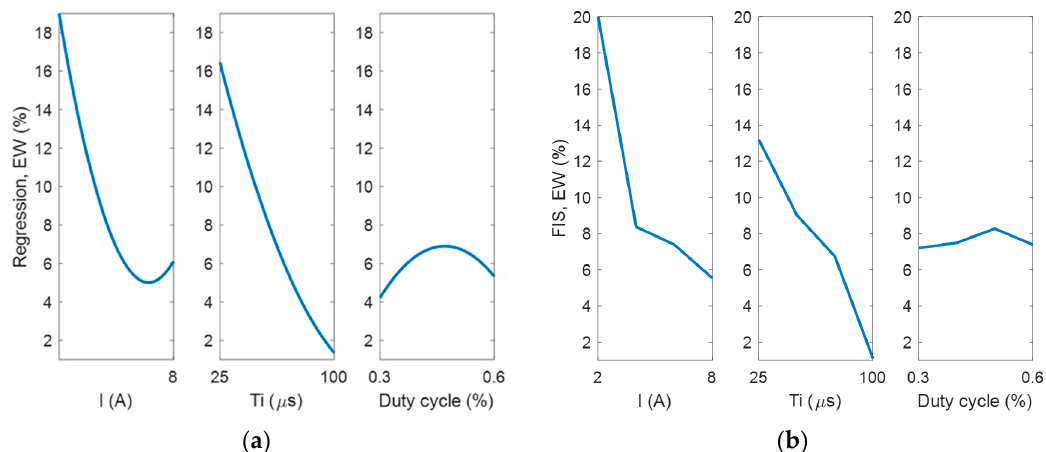
Figure 10. Main e ff ects plot for EW in the case of positive polarity: ( a ) obtained from the regression [2]; ( b ) obtained by using the FIS.